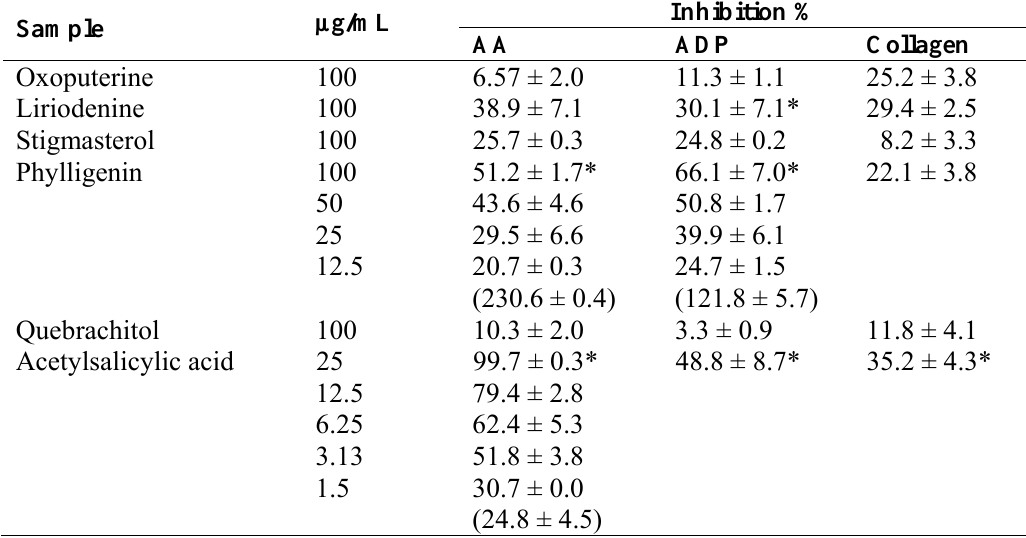
Table 2. Percentage inhibition of isolated compound of Mitrphora vulpina and aspirin on platelet aggregation of human whole blood induced by AA (0.5 mM), collagen (2 μ g/mL) and ADP (10 μ M) and their IC 50